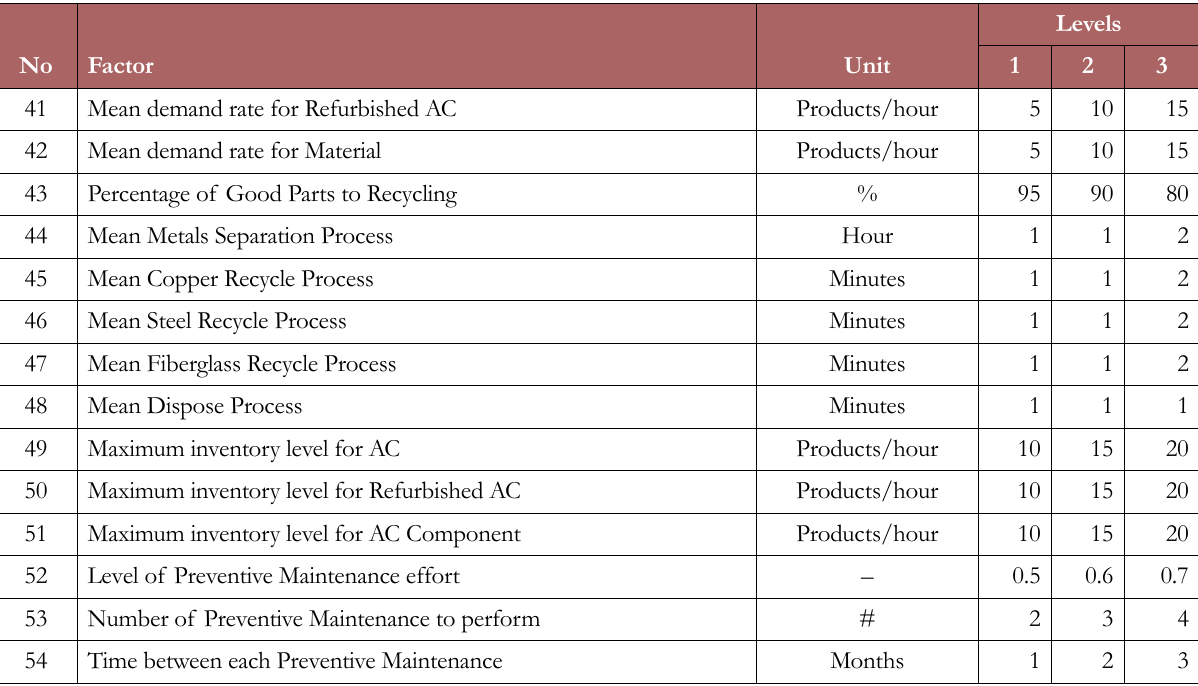
Table 3. Factors and factor levels used in design-of-experiments